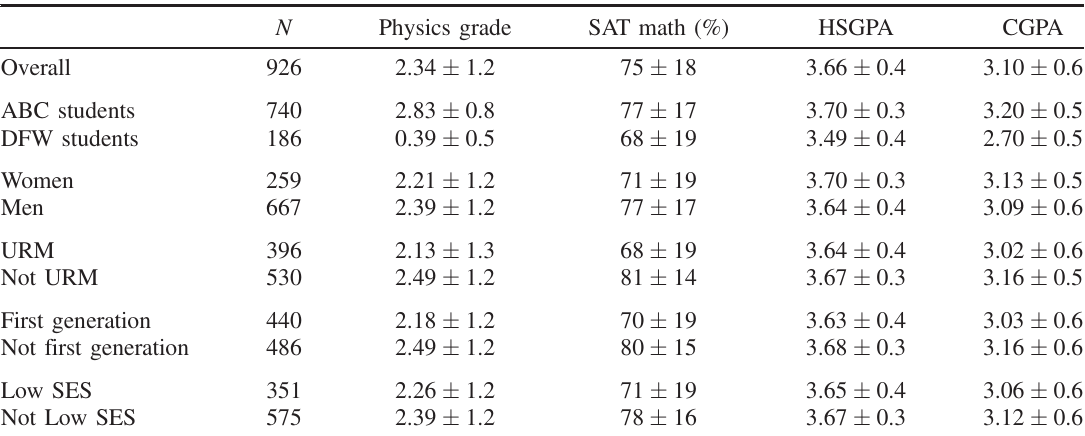
TABLE IV. Descriptive statistics for sample 3. All values are the mean (cid:2) the standard deviation.